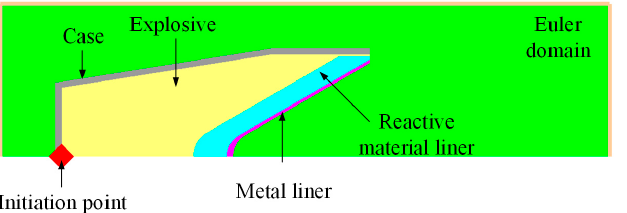
Figure 7. Numerical model of the jet forming for the SC with reactive material composite